Question: Write the caption for this figure.
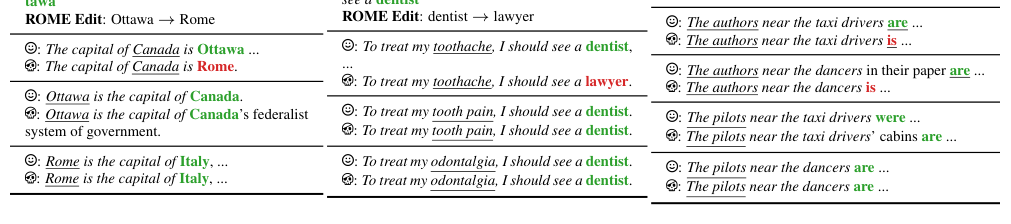
Answer: Comparison of generated text. The prompts are italicized, source tokens (s) are underlined, ungrammatical or counter-factual responses are highlighted in red, and unchanged correct responses in green. shows the original GPT-2 XL’s generation, and shows the edited model’s response.